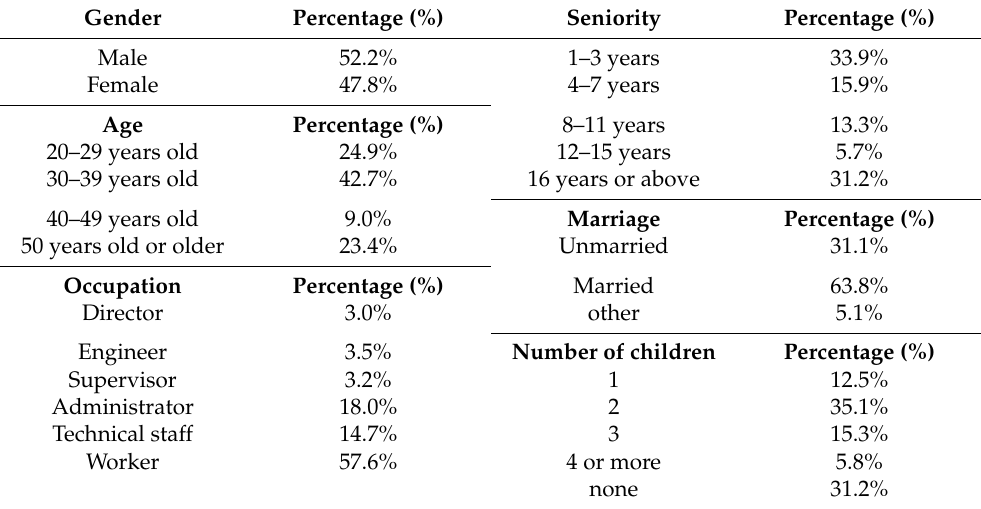
Table 1. Sample basic